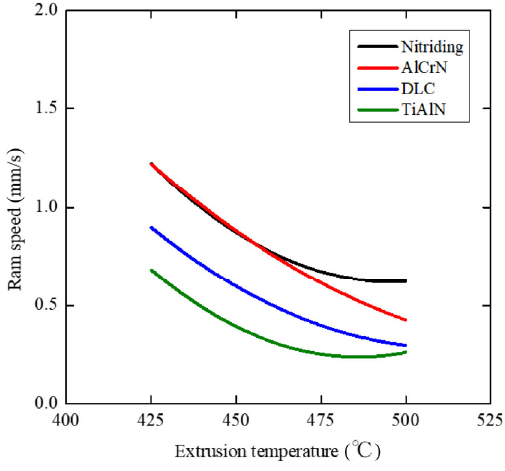
Fig. 11 Extrusion limit diagram for tearing of A7075 alloy. The die was coated using nitriding